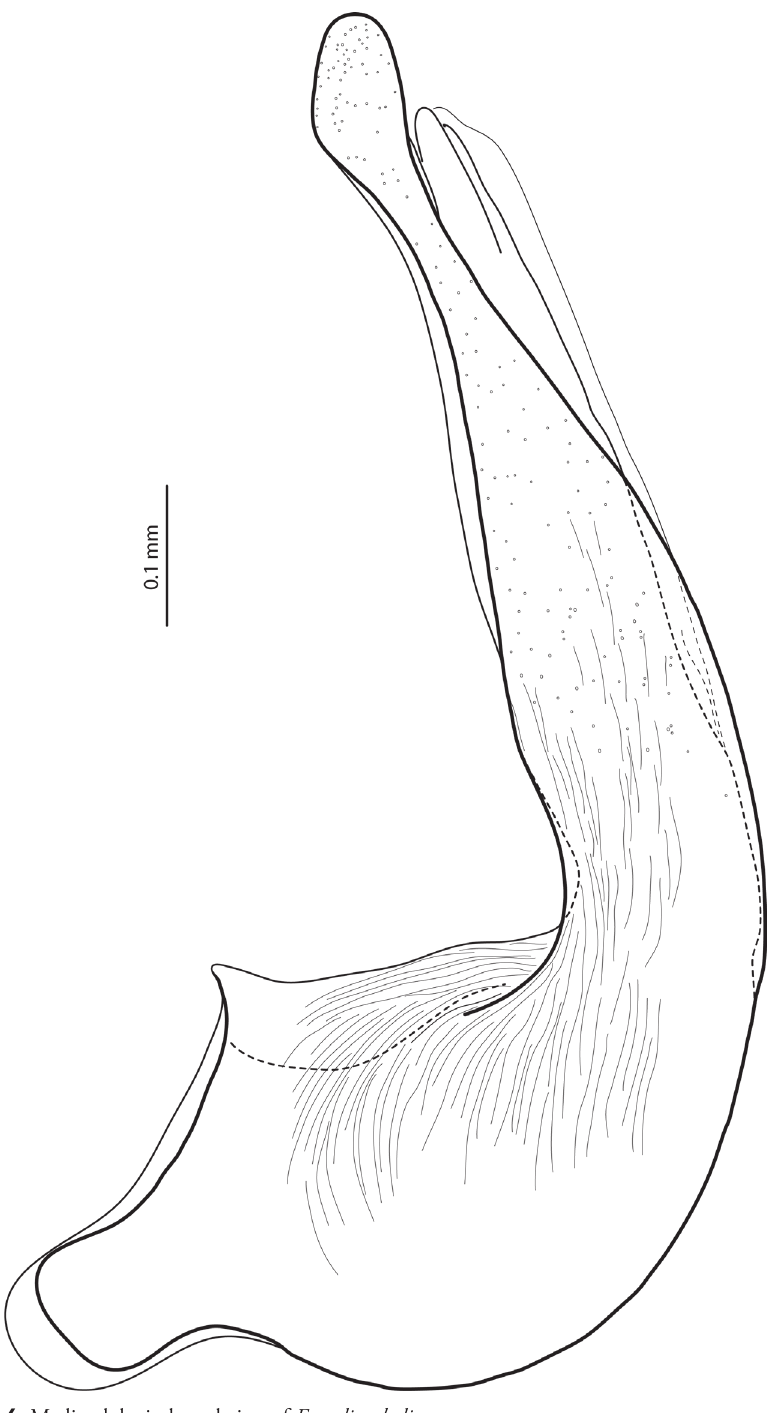
Figure 6. Median lobe in lateral view of Exocelina baliem sp.